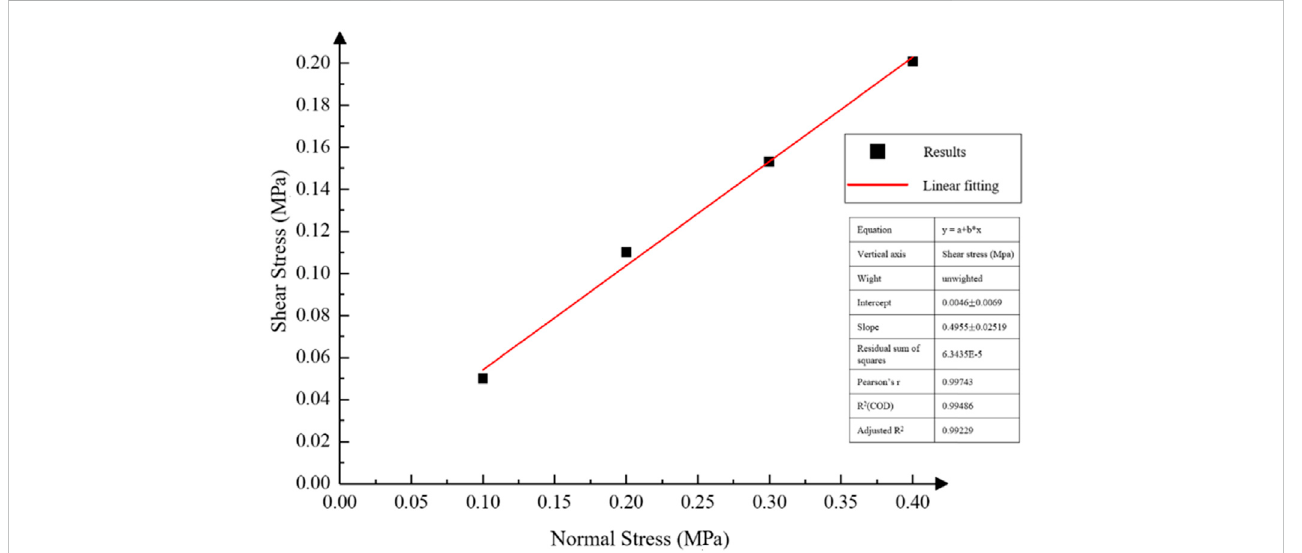
FIGURE 5 Relationship between cohesion and moisture